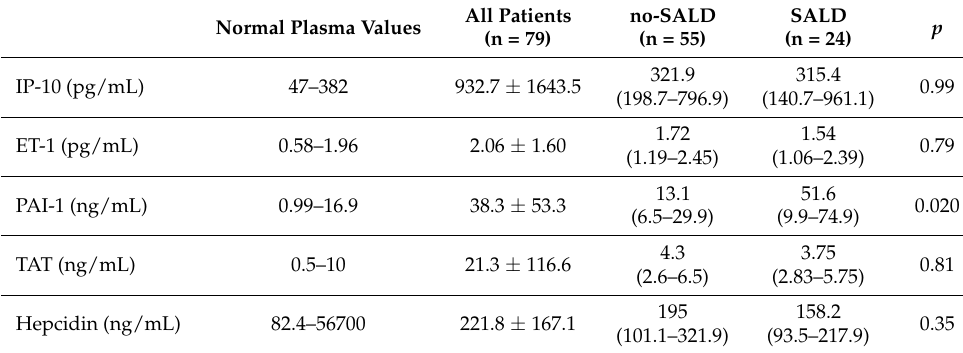
Table 5. Analysed